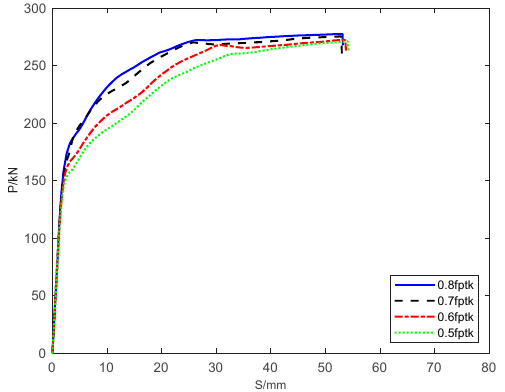
Figure 18. Effect of tension control stress on mid span deflection.